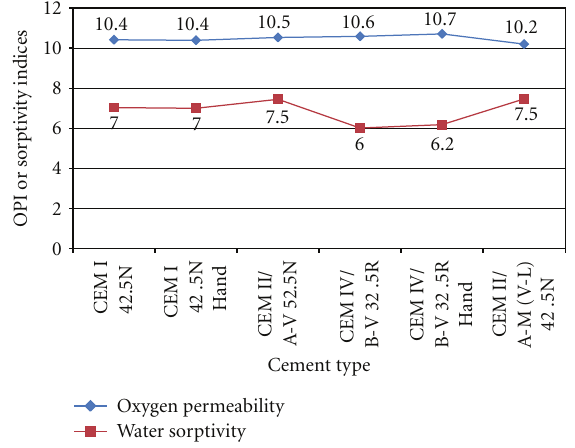
Figure 8: OPI and water sorptivity indices for di ff erent cement types at a w/c ratio of 0.4.